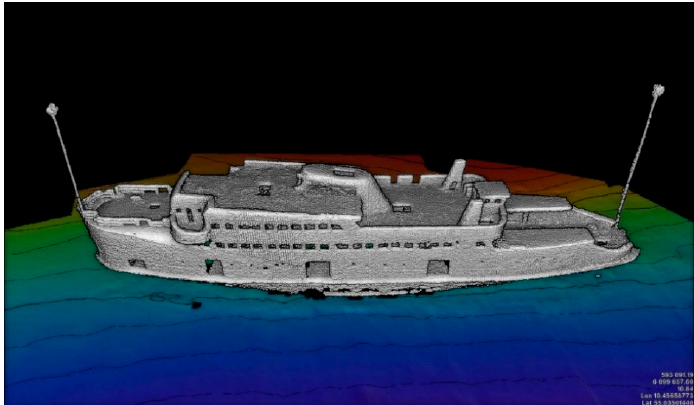
Figure 1. Sensory scan (side-scan sonar image of the sunken ferry) of the sunken ferry. Both ends of the ferry lines are attached to a buoy on the surface. With permission from: SensorySurvey.